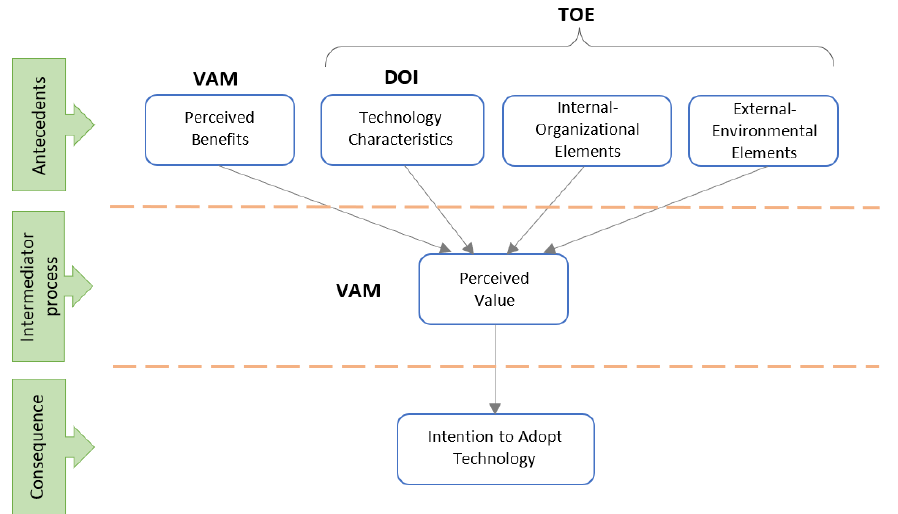
Figure 2. The integration of VAM [78], DOI [83], and TOE [87] (the integration method adapted from [92]). Table 1. Mapping matrix of VAM, DOI, and TOE constructs used in this study.